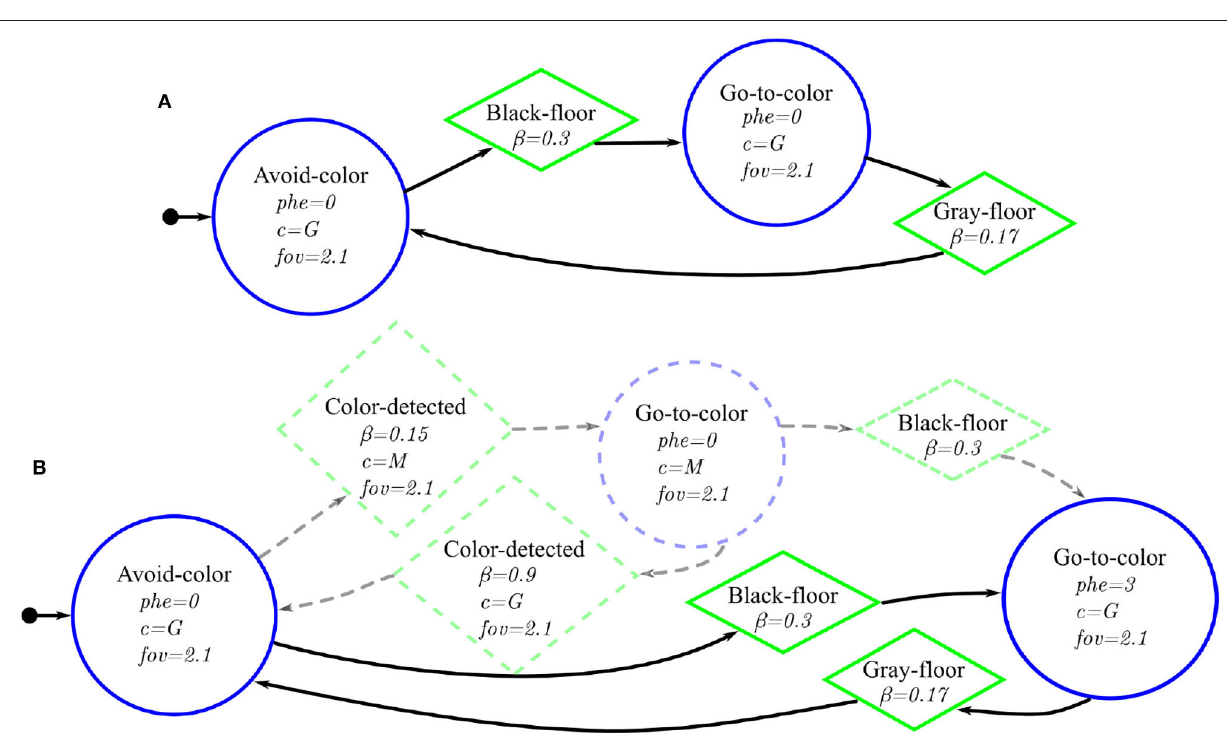
FIGURE 7 | Probabilistic finite–state machines for the two FORAGING experiments: (A) Basic- FORAGING , and (B) Phormica - FORAGING —the difference between the two probabilistic finite-state machines is highlighted with dashed-lines. In both finite–state machines, a circle, a lozenge, and an arrow with a small circle represent the states, transition, and initial state,